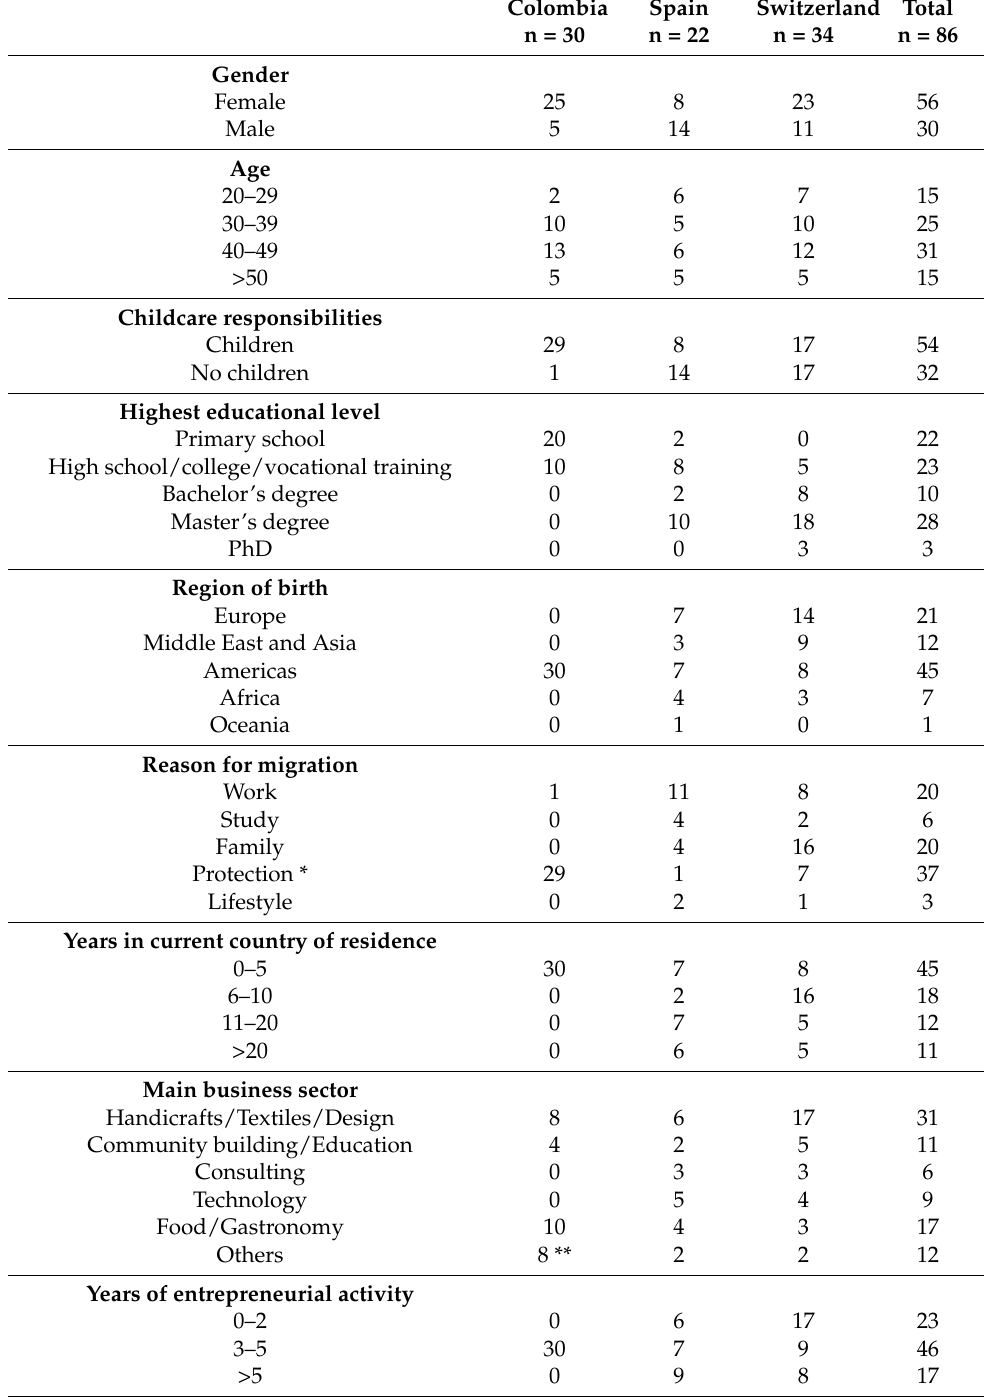
Table 1. Socio-demographic characteristics of the interviewed